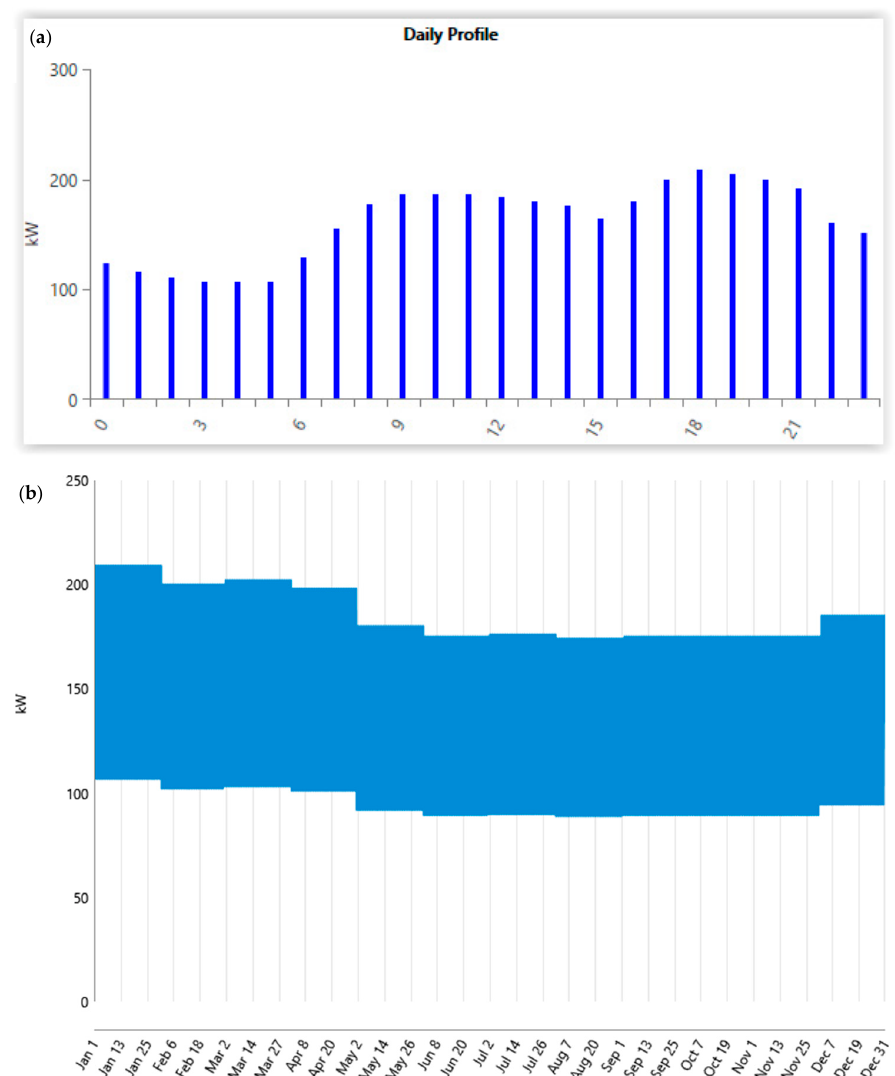
Figure 12. The daily ( a ) and monthly ( b ) load of Stewart Island. The power that can be output by single wind and tidal turbines at the Foveaux site are shown in Figure 13. The maximum outputs of the selected wind and tidal turbines are 100 kW and 39.3 kW, respectively.